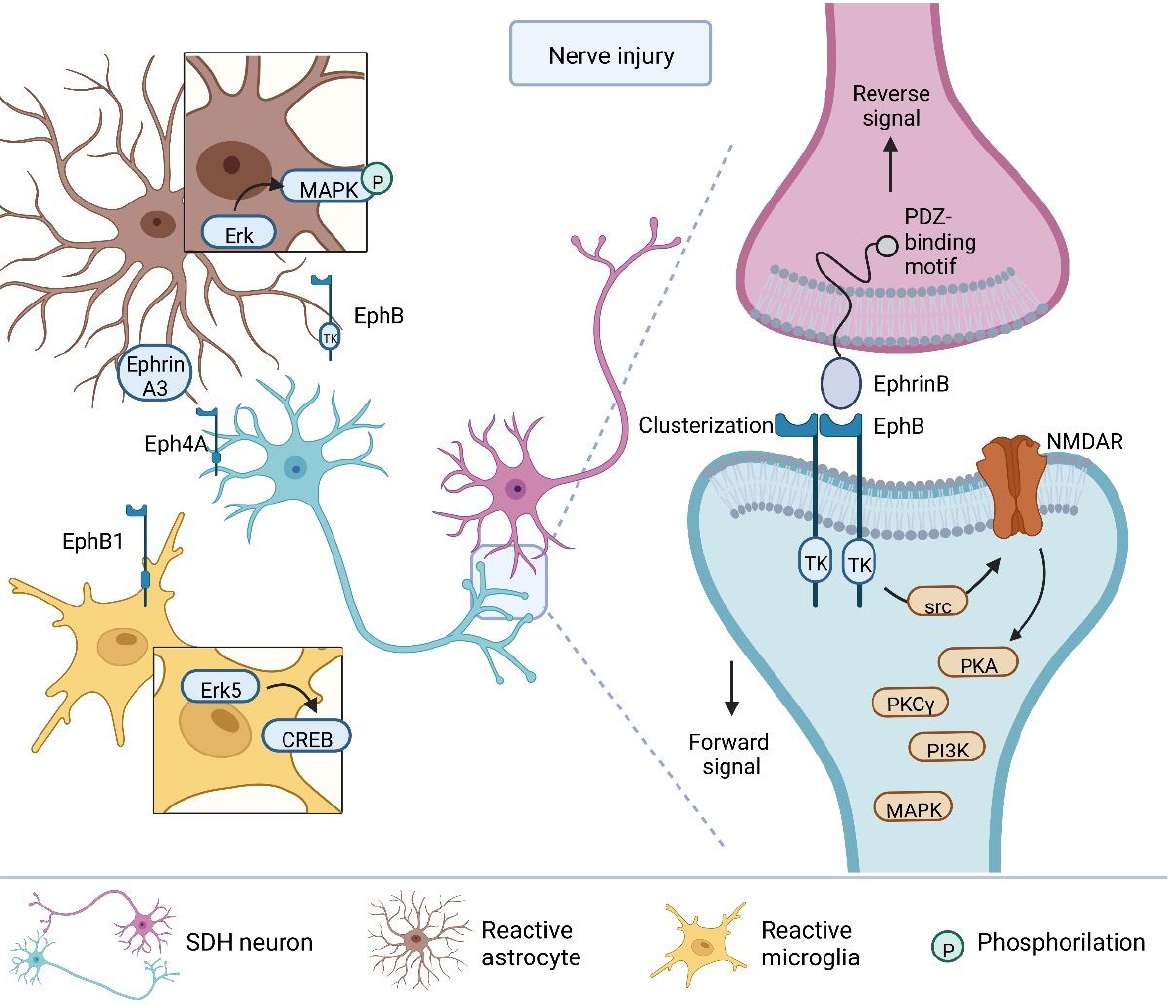
Figure 2. Eph/ephrin signaling in nerve injury causes overactivation of nociceptors, glial cells, and synaptic plasticity. EphB receptors belong to a family of RTKs and bind the membrane-bound ligand ephrinB. In pain states, this interaction helps the polymerization of the receptor and amplification of the forward signal towards overexcitability of sensory neurons (via NMDAR) and modification of synapses. In chronic inflammatory pain, the dendritic EphA4 is upregulated following neuronal damage, interacts with ephrinA3 (astrocytic), and activates its cascade involving ERK and activation (phosphorylation) of MAPK. After injury, Erk5 and CREB are activated, possibly due to EphB1 triggering. TK, tyrosin kinase; Erk, extracellular signal-regulated kinase; MAPK, mitogen-activated protein kinase; CREB, cAMP response element-binding protein; NMDAR, N-methyl-D-aspartate receptor; PKA, protein kinase A; PKC γ , protein kinase C gamma; PI3K, phosphatidylinositol 3-kinases.